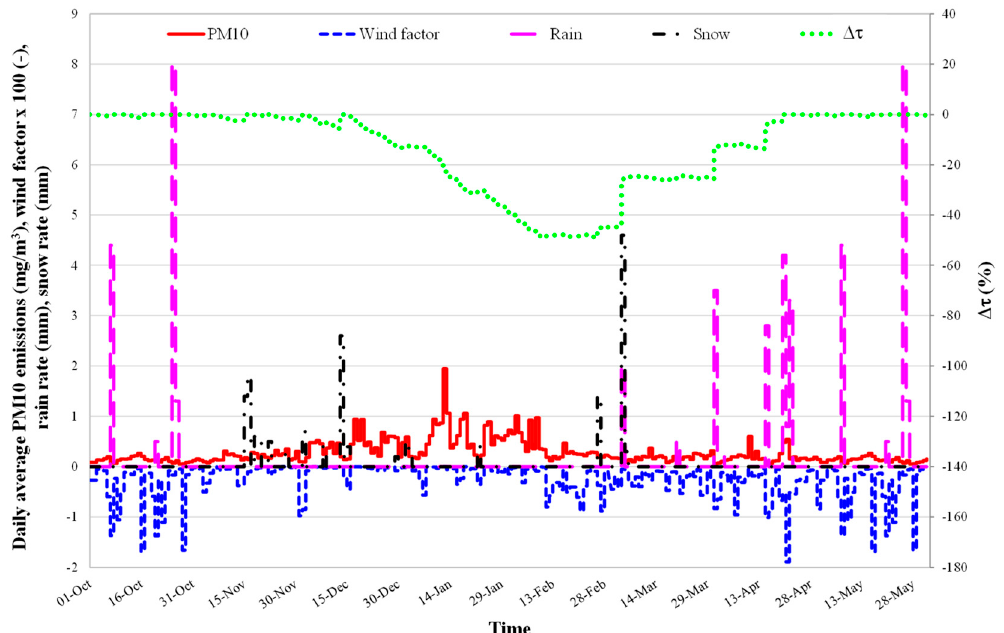
Figure 10. The experimental daily average PM10 emissions, wind factor, rain rate and snow rate in Ulaanbaatar from October 2015 up to May 2016, together with the percentage reduction of daily average glass tube transmittance due to the dust deposition.